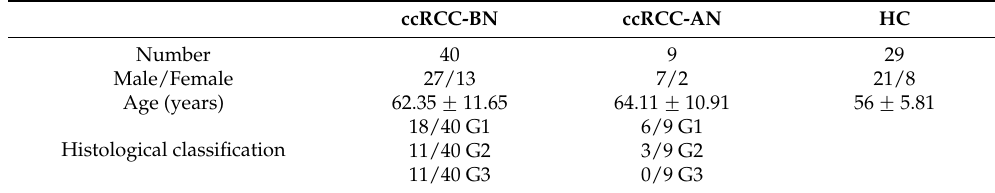
Table 1. Characteristics (number, sex, age, histological classification) of patients and healthy controls, whose urine samples were provided. ccRCC-BN = patients with ccRCC before nephrectomy, RCC-AN = ccRCC patients after nephrectomy, HC = healthy